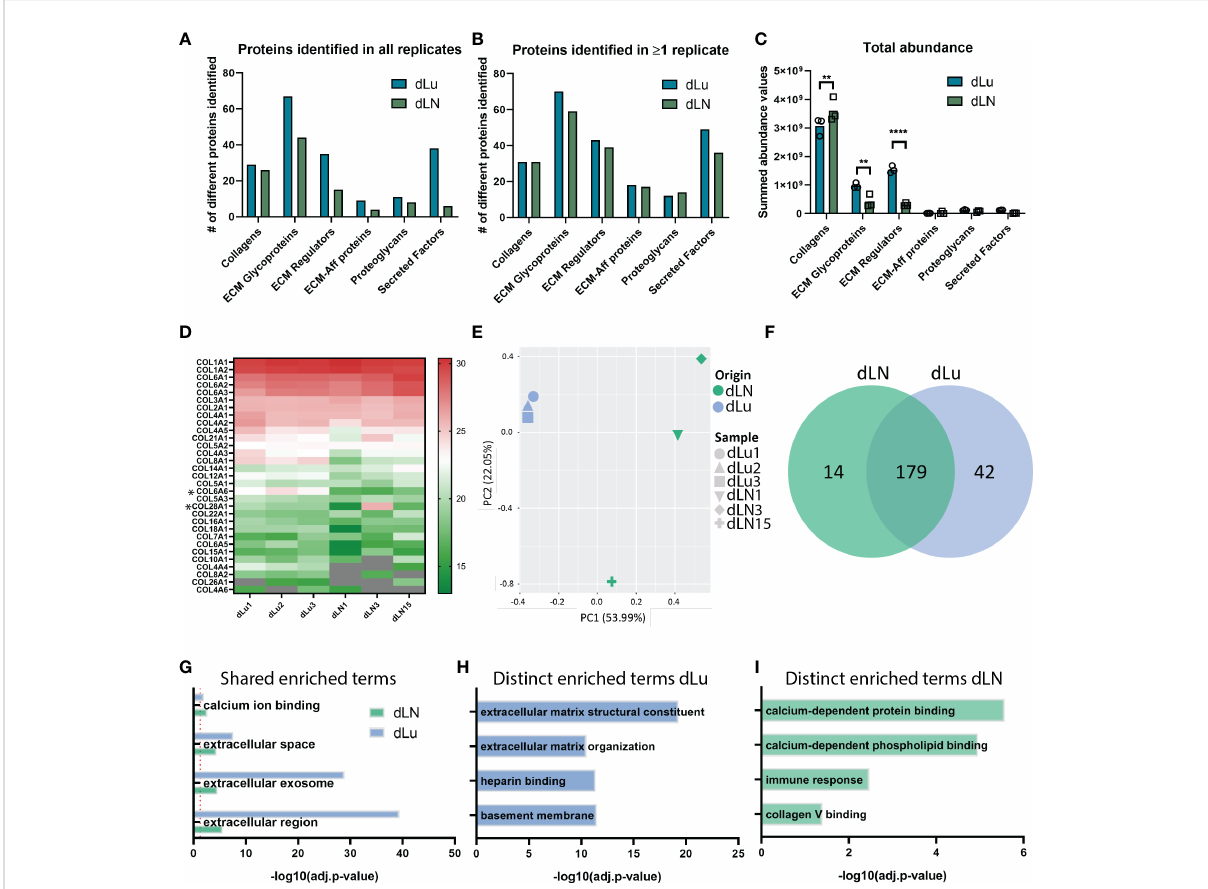
FIGURE 4 Analysis of global ECM proteome derived from decellularized lung and lymph node tissue. (A, B) Global matrisome protein composition identi fi ed by Mass Spectrometry displaying the total number of unique proteins identi fi ed in all biological replicates (A) or identi fi ed in at least 1 biological replicate (B) . Only proteins overlapping with MatrisomeDB classi fi cation for ECM-related proteins are included. (C) Total abundance values per ECM-related protein category. A two-way ANOVA with multiple comparisons per matrisome category statistical analysis was performed (Collagen p=0.006; ECM Glycoproteins p=004, ECM Regulators p<0.0001). (D) Heat map displaying the relative log 2 (abundance) values for all identi fi ed collagen subunits. Grey color indicates that no abundance value was present. *p < 0.05. (E) Scatter plot based on principal component analysis (PCA) displays a global separation between ECM protein composition of dLN and dLu. (F) Exclusive and shared proteins identi fi ed in dLu and dLN. (G – I) Enrichment analysis of selected biological processes and pathways for protein abundance differences as displayed in (E) for dLu and dLN. Shared enriched processes are processes that are signi fi cantly enriched in both decellularized tissues, distinct enriched processes are processes that are exclusively enriched in either dLu or dLN. For all mass spectrometry analysis dLu1, dLu2, and dLu3 were used for lung, and dLN1, dLN3, and dLN13 were used for lymph node. **= p-value < 0.005; **** = p-value <